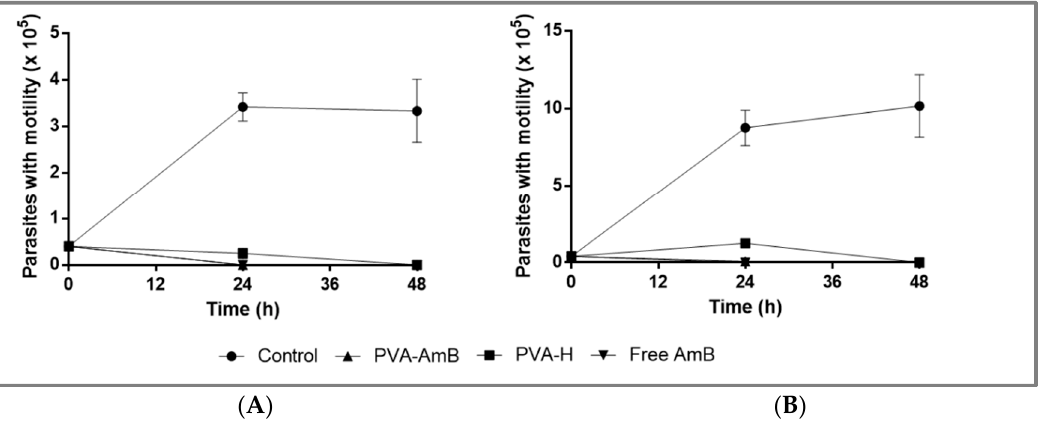
Figure 6. Leishmanicidal activity of the PVA–H and the PVA–AmB against ( A ) Leishmania amazonensis and ( B ) Leishmania